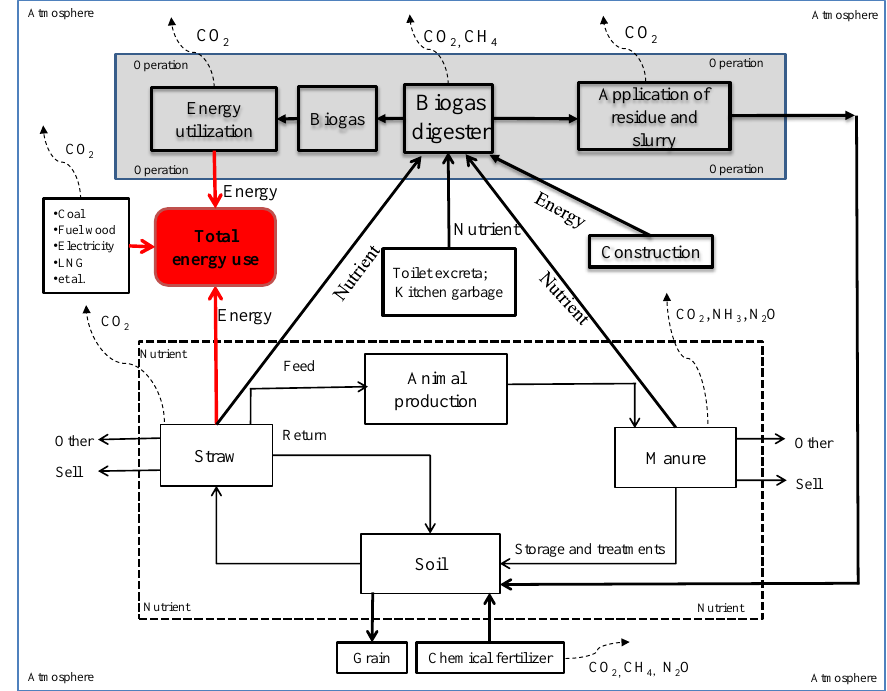
Figure 2. Life cycle assessment of GHG mitigation from biogas facilities. The solid line represents the digester operation flow, energy and materials, and the dotted arrow represents GHG emissions from biogas facility and associated farming system. The dotted box represents nutrient recycling within farming system.